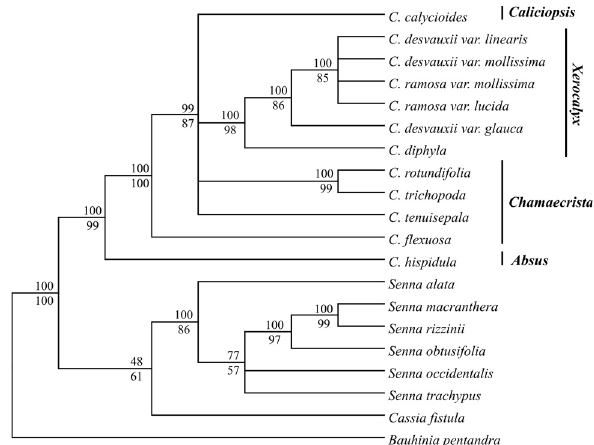
Figure 2 - Majority rule consensus tree based on the Bayesian analysis of the trnE-trnT intergenic spacer data set. Bauhinia pentandra was set as outgroup. Numbers above lines are Bayesian posterior probability values and below lines are bootstrap (1,000 replicates) support values from maxi- mum parsimony analysis. Sections of Chamaecrista follow Irwin & Barneby